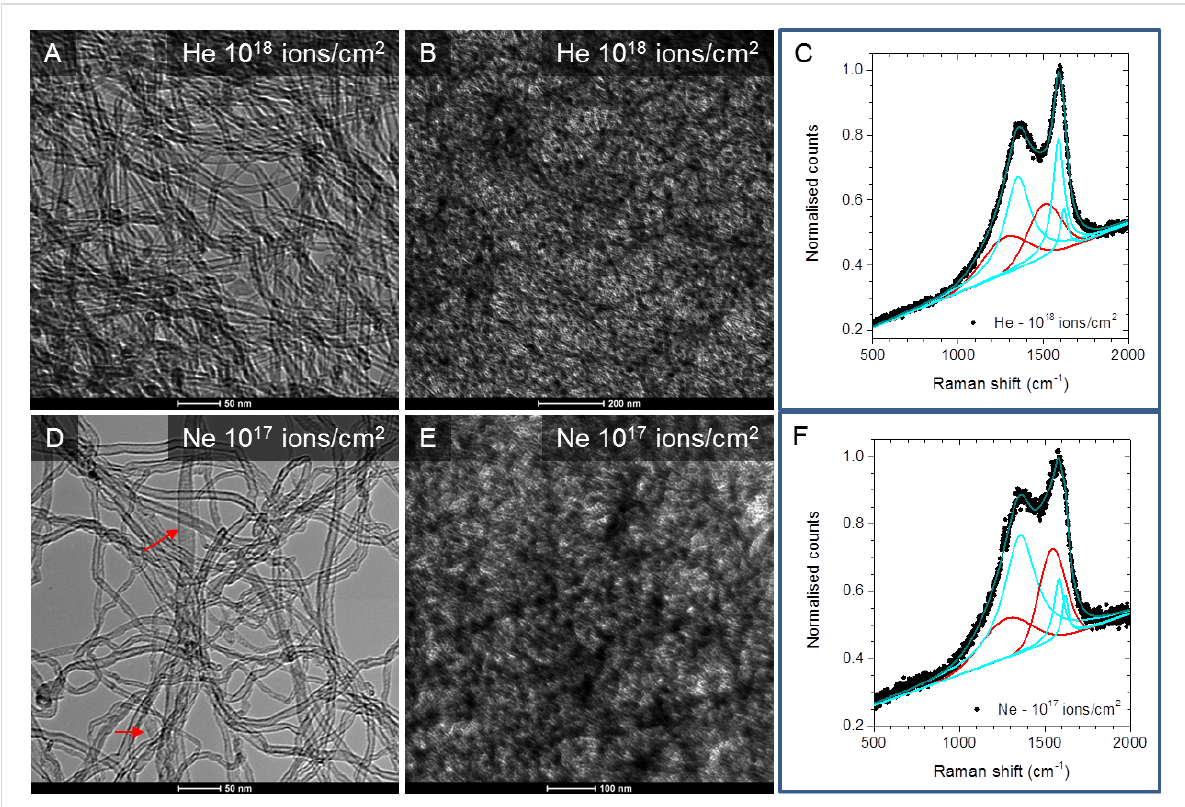
Figure 3: TEM images and Raman spectra after: (A–C) 25 keV He + irradiation with a fluence of 10 18 ions/cm 2 (D–F) 25 keV Ne + irradiation with a fluence of 10 17 ions/cm 2 . While the thinner areas in both cases (A, D) appear to be relatively less damaged due to ion irradiation, the thicker sample areas (B, E) display diffuse contrast characteristic of partial amorphization, with most damage evident for the Ne + irradiation. The arrows in (D) point to larger structures formed after ion irradiation. Plausible explanations are either by unzipping or other mechanisms of damage formation of MWCNT due to Ne + irradiation. The structural features observed in these TEM images correlate very well with corresponding Raman spectra (C, F). In the deconvoluted spectra, Lorentz functions in cyan denote the D, G and D’ peaks while the Gaussian contributions from highly disordered areas are coloured in